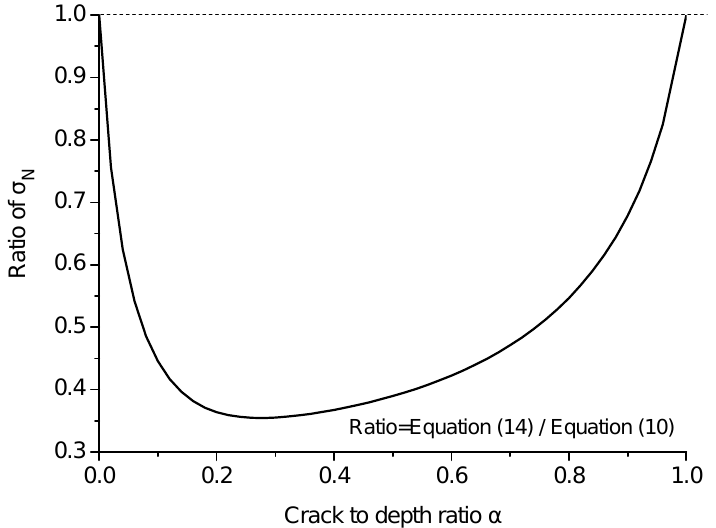
Figure 6. Ratio of nominal strength σ N given by Equations (14) and (10) versus the crack to height ratio α